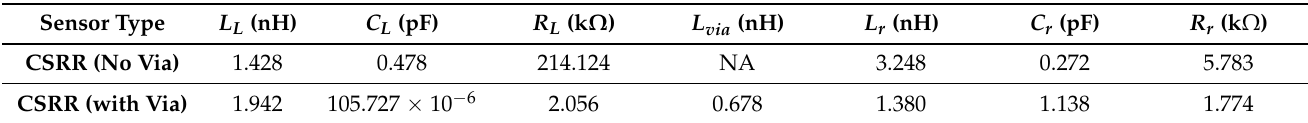
Table 2. Extracted lumped elements of the sensors.